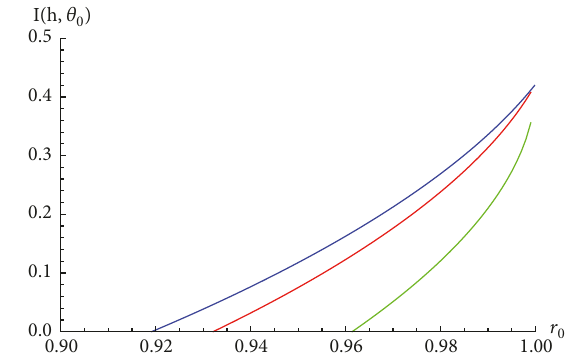
Figure 8: Relation between 𝐼(ℎ, 𝜃 0 ) and 𝑟 0 for the case 𝑟 𝑚𝑖𝑛 = 50,𝑟 = 1 . The green line, red line, and blue line correspond to ℎ 𝑄 = 0.5, 0.52, 0.54 , respectively.